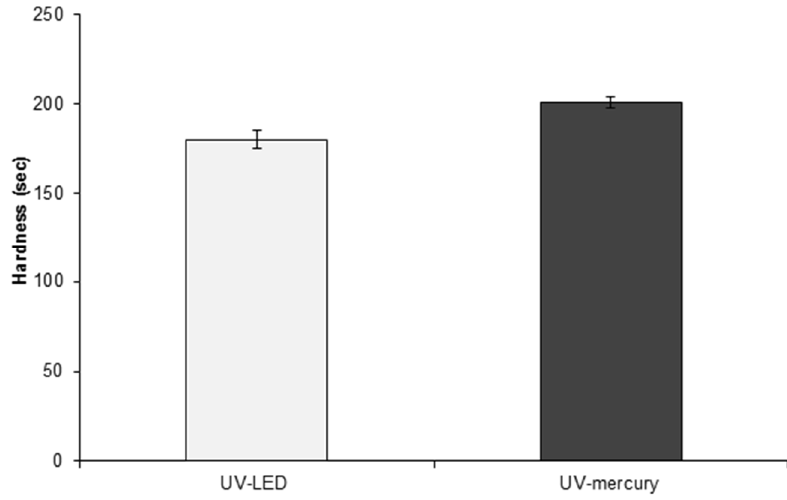
Figure 6. Konig hardness of the UV-water-based